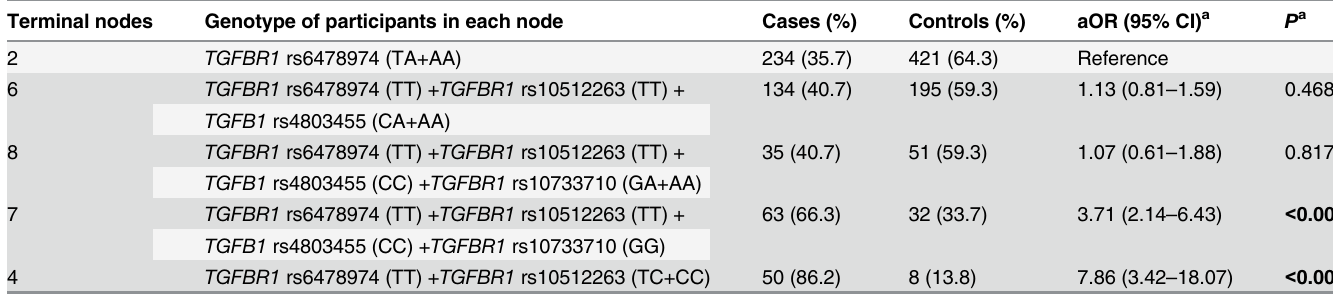
Table 3. Conjoint analysis of the effects of individual tSNPs on EC risk by CART.